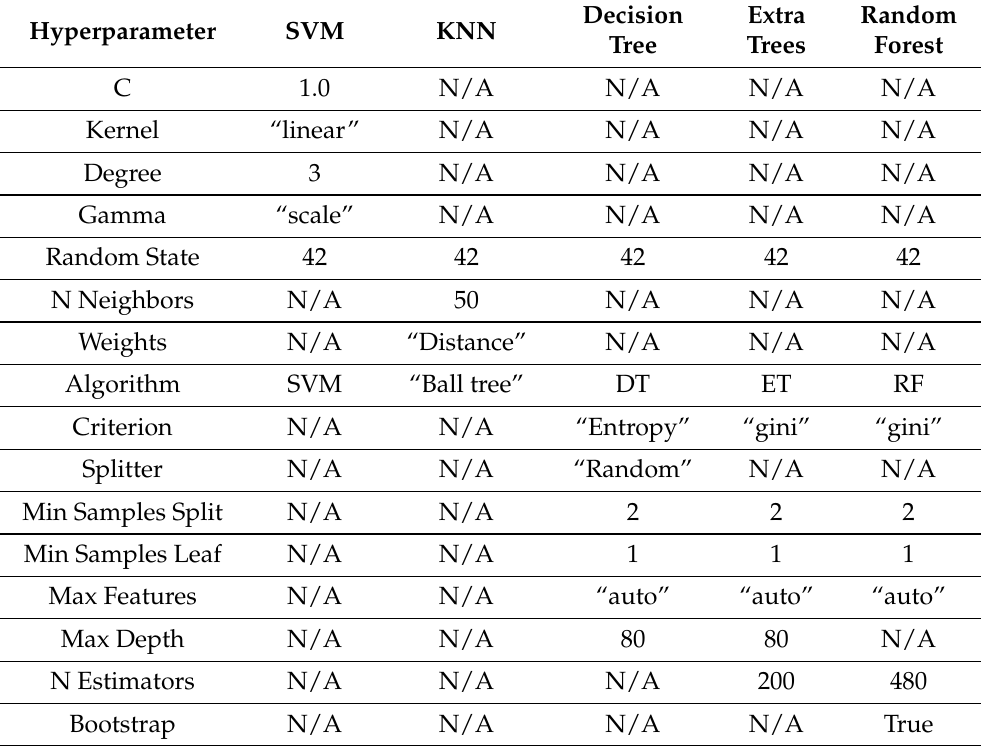
Table 5. Hyperparameters of ML